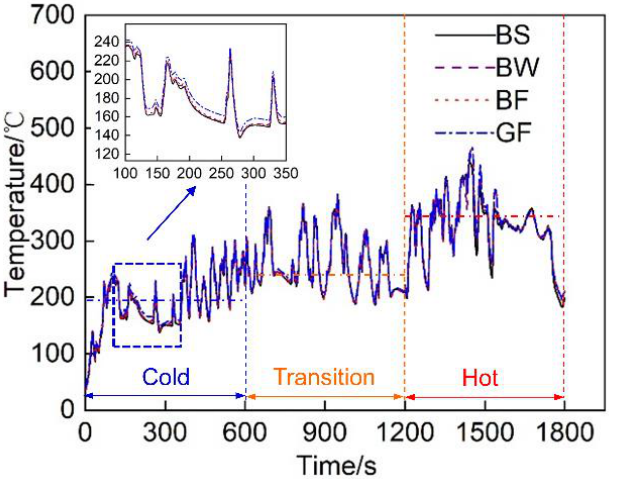
Figure 4. Temperature at the T2 measurement point of the exhaust pipes with different covering schemes over time.